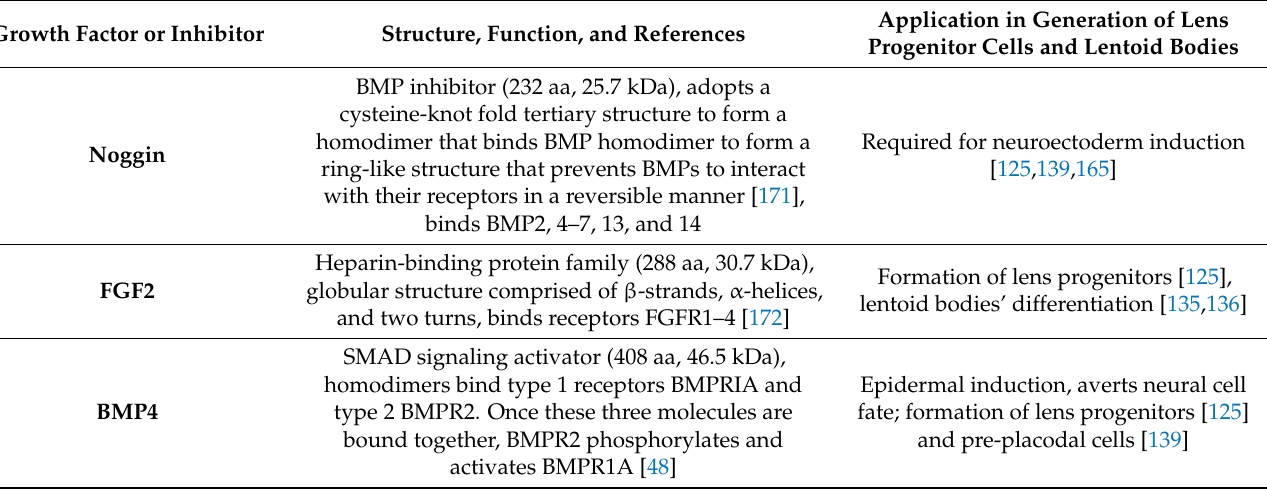
Table 3. Growth factors and small-molecule drugs used in lens progenitor cell and lentoid bodies’